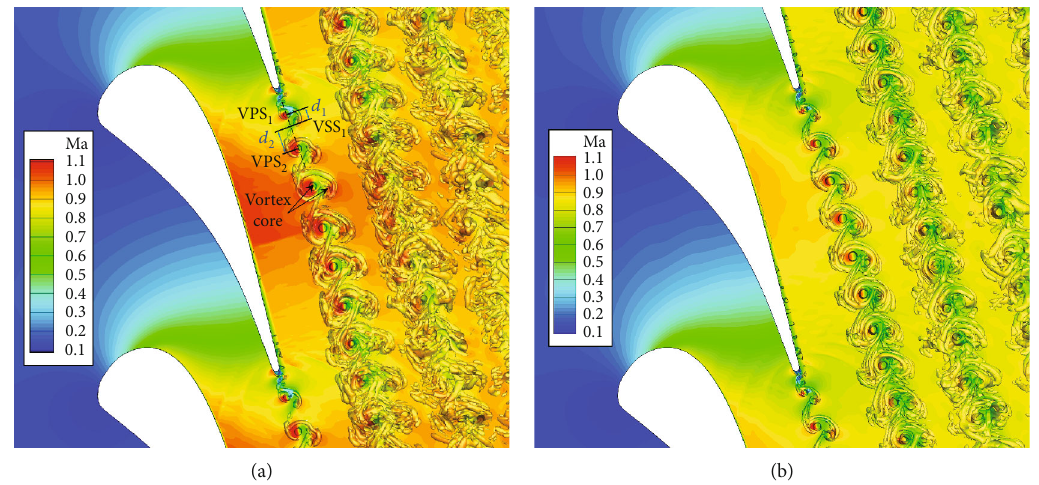
Figure 7: The length characteristics of wake vortex: (a) fl ow condition MUR235; (b) fl ow condition MUR129.